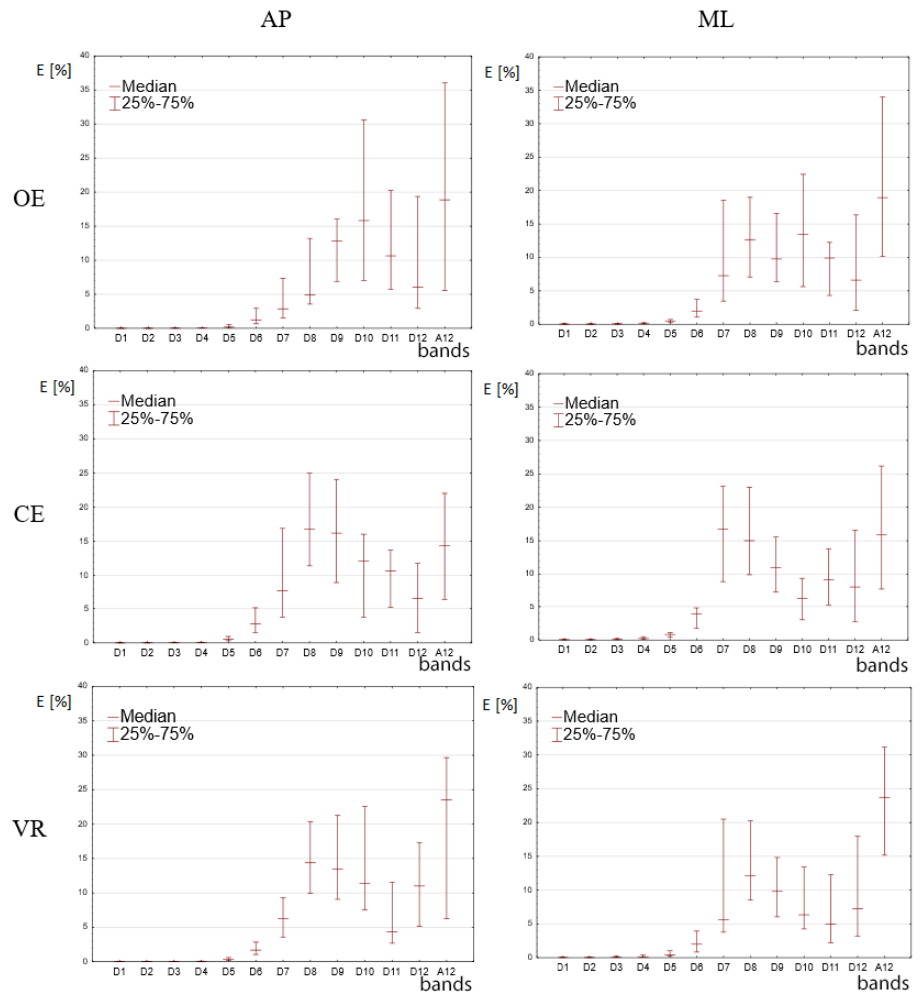
Figure 4. Percentage energy values for individual signals occurring during the decomposition process of the CoP displacement signal in the Anterior-Posterior (AP) and Mediolateral (ML) planes. Results are from the tests with open eyes (OE), closed eyes (CE) and VR (Virtual Reality) projection in the Head Mounted Display (HMD) VR system.